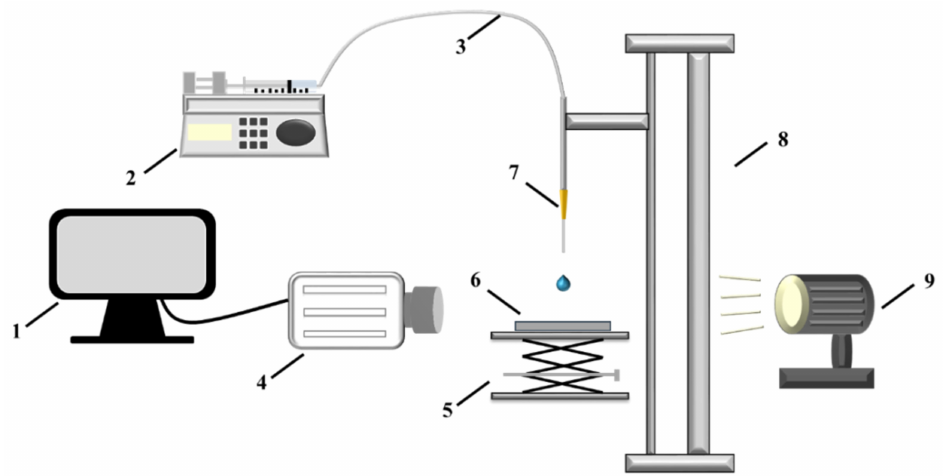
Figure 4. Experimental setup for measuring the droplet impact and spreading characteristics on the substrate surface: 1, Computer; 2, Injection pump; 3, Catheter; 4, High-speed camera; 5, Carrier table; 6, Surface; 7, Needle; 8, High-precision linear slide; 9, Light